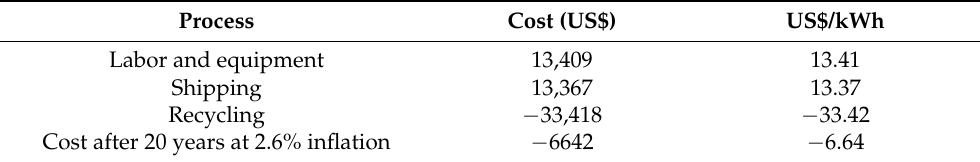
Table 9. Costs of lithium-ion battery decommissioning in 2038. Source: [39].